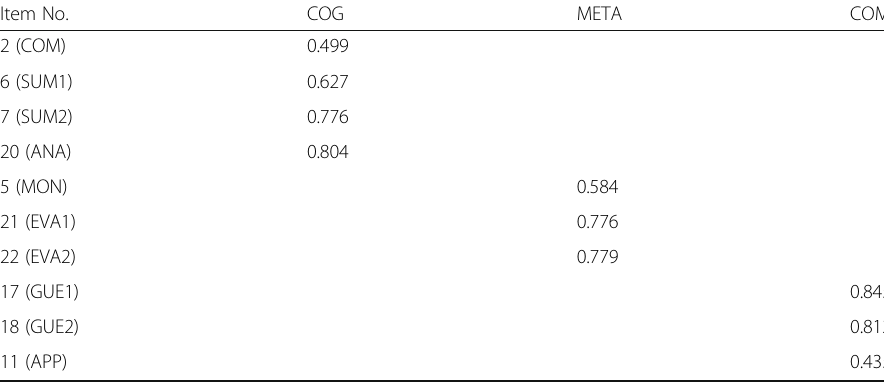
Table 5 EFA results of the PSUI: Oblimin Rotation Item